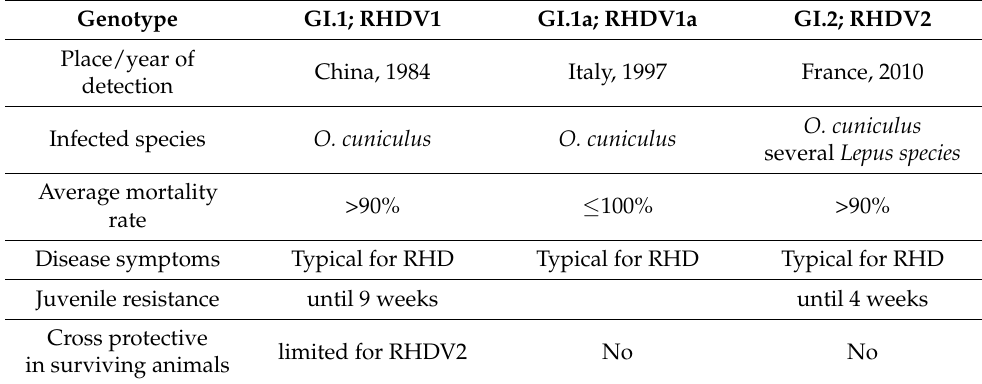
Table 2. Comparison between the main types of Lagovirus europaeus